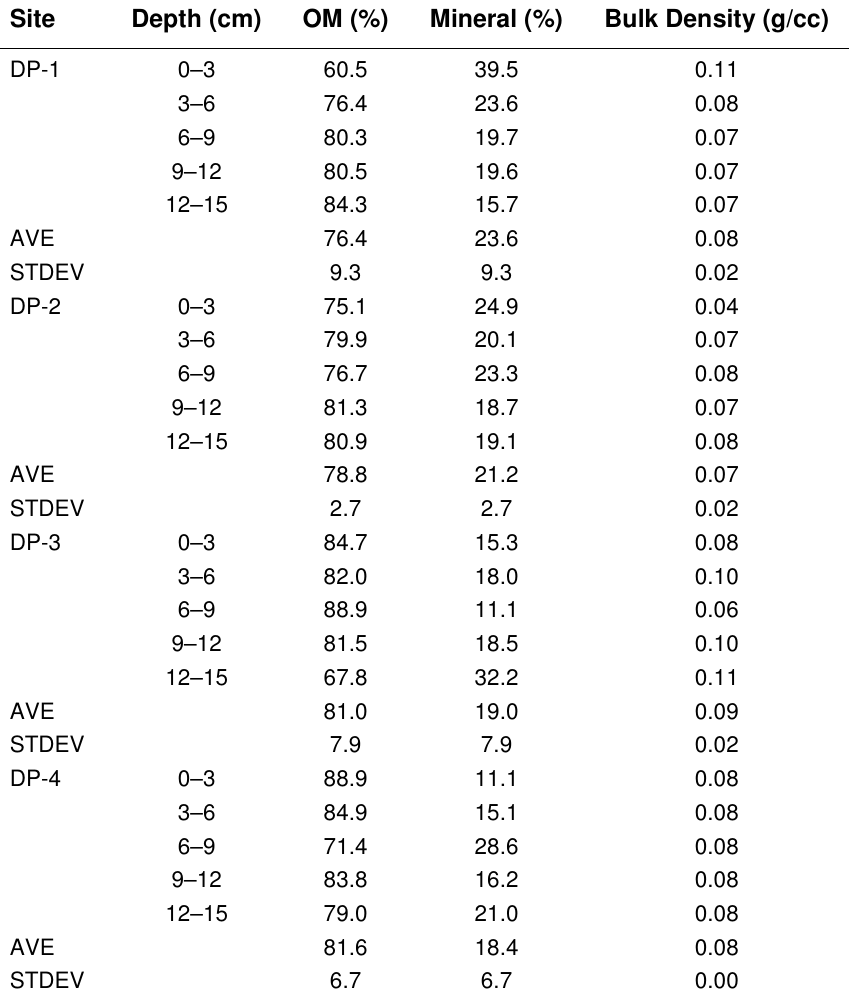
Profile of Average Soil Organic Matter (OM), Mineral Content, and Bulk Density (3-cm Depth Increments) of Sediment at Four Sites within